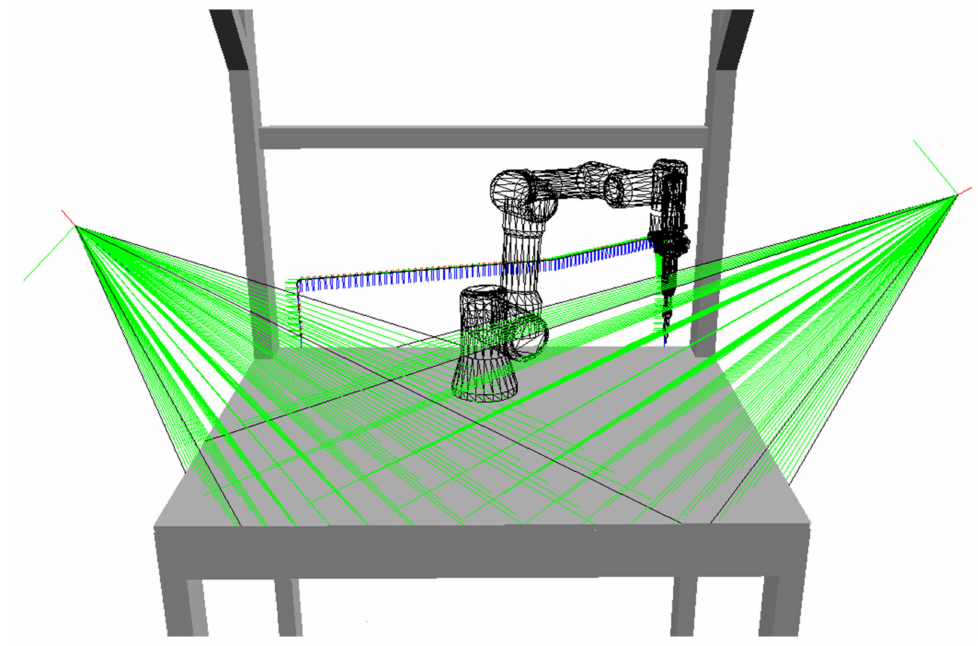
Figure 19. Demonstration of a very bad workplace coverage achieved by subject 11 using two